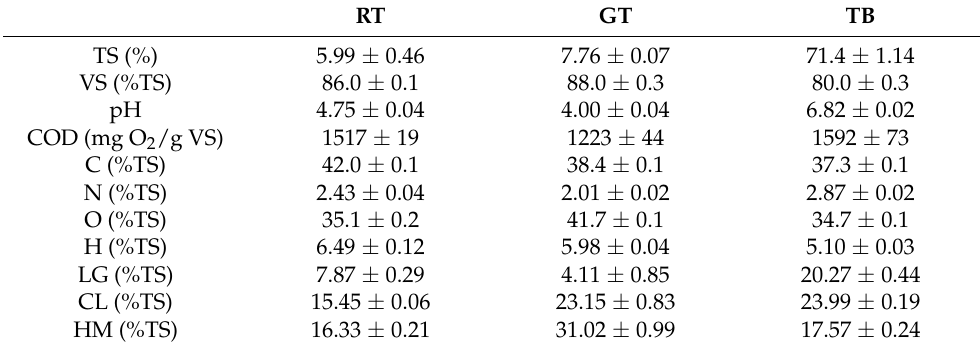
Table 2. Characterization of rotten tomato (RT), green tomato (GT), and tomato plant